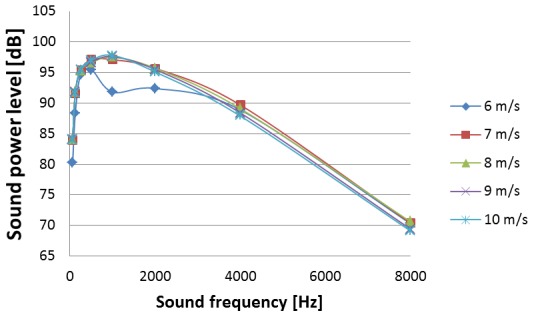
Training and checking data for wind turbine noise assessment.